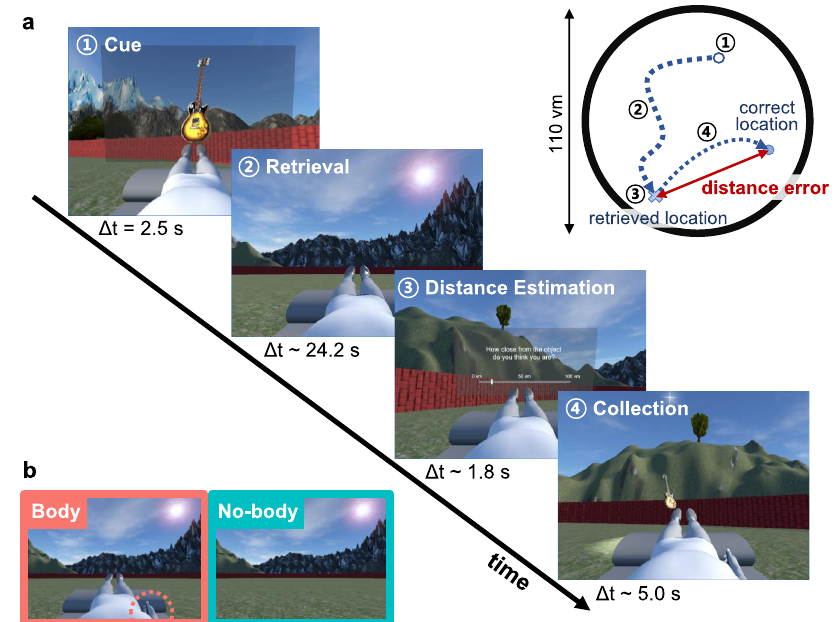
Fig. 1 Spatial navigation task and experimental BSC conditions. a The spatial navigation task consisted of six sessions with two experimental conditions. Each session started with an encoding phase, in which participants had to memorize the locations of three objects. Following encoding, participants performed 14 trials with the following steps: (1) Cue: a target object was provided (2.5 s); (2) Retrieval: they had to recall and reach the original object location (self-paced, average 24.2 s); (3) Distance estimation: they estimated the distance error they committed (self-paced, average 1.8 s); (4) Collection: a target object appeared at its original location and participants were asked to navigate to it (self-paced, average 5.0 s). b In the Body condition, a body- shaped avatar (congruent with the posture and hand motion of the participant in the scanner) was seen by participants as part of the virtual scene during the entire procedure. In the No-body condition, the same scenes were displayed, but without the avatar (as is usually done during spatial navigation studies). Δ t mean duration, vm virtual